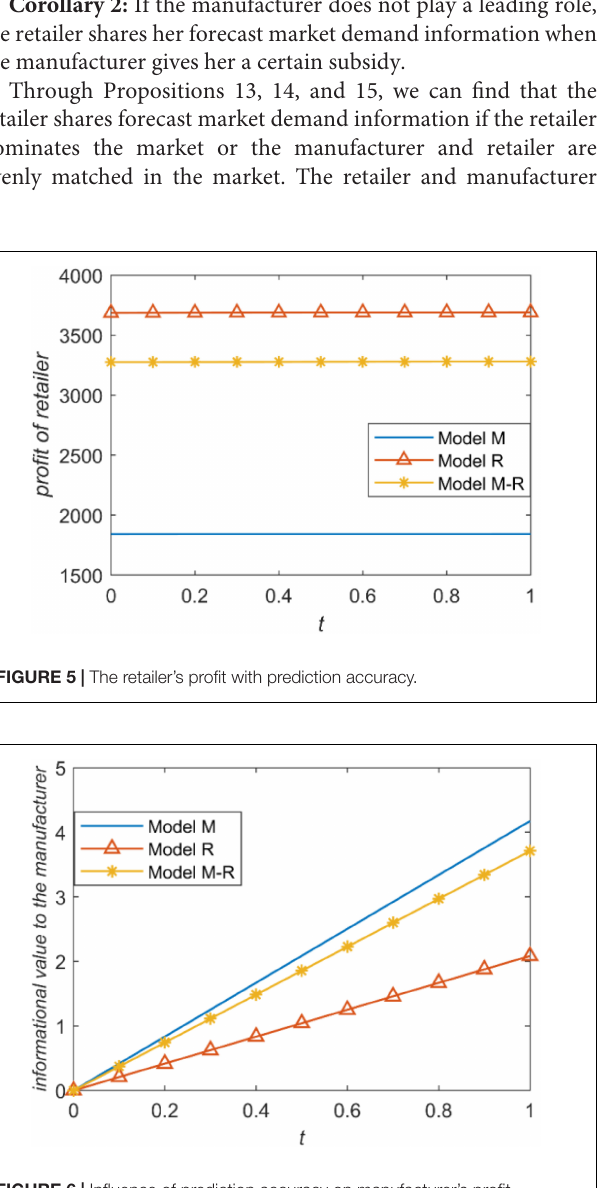
FIGURE 4 | The manufacturer’s profit with prediction accuracy.